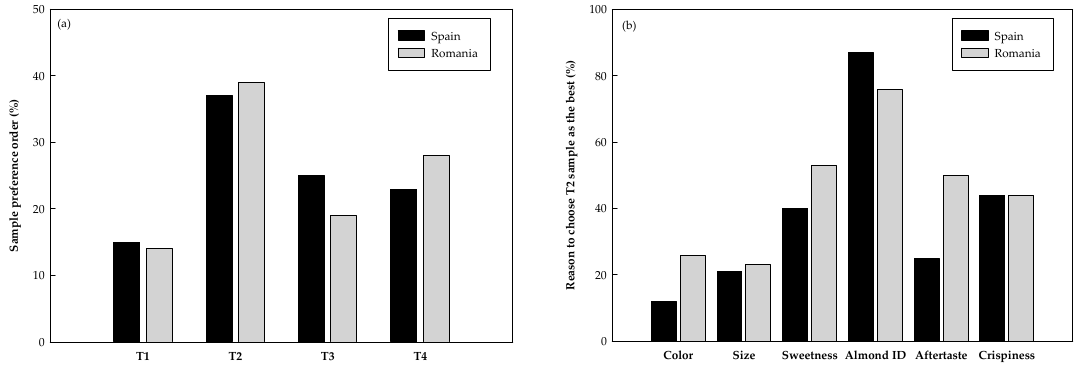
Figure 1. Purchase intent of Spanish and Romanian consumers regarding the studied almonds ( a ), and their reason to choose T2 almonds as the favorite ones ( b ).